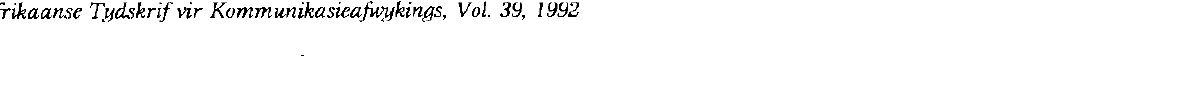
Figure 13: How does a symbol system differ from pictures?